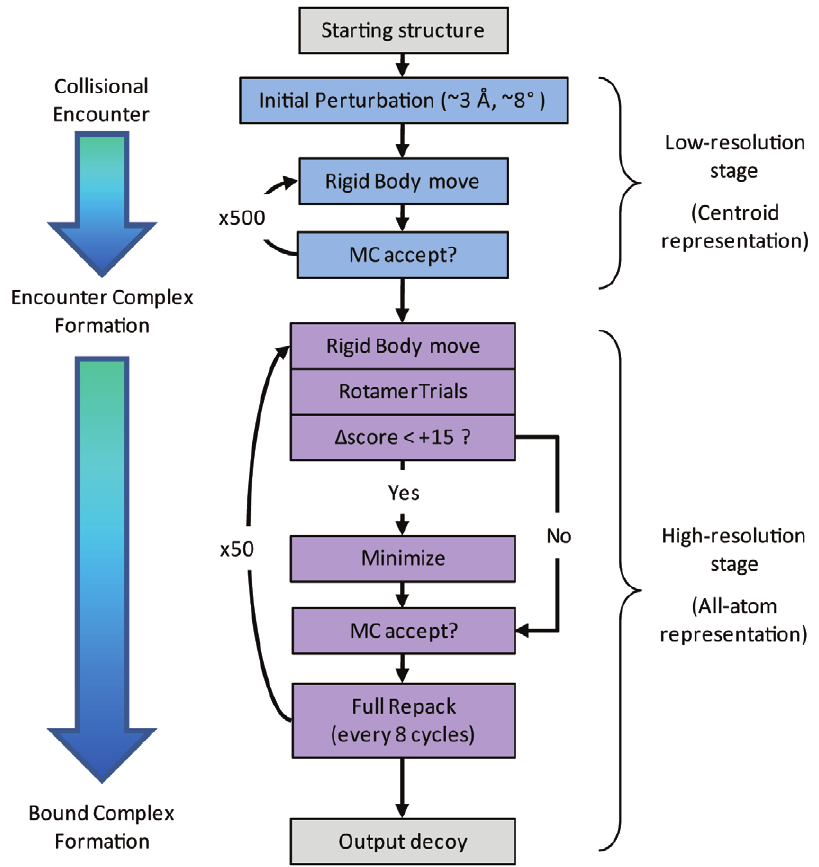
Figure 1. The RosettaDock algorithm. RosettaDock is a multi-scale Monte-Carlo based algorithm that roughly models encounter complex formation followed by a transition to a bound state.